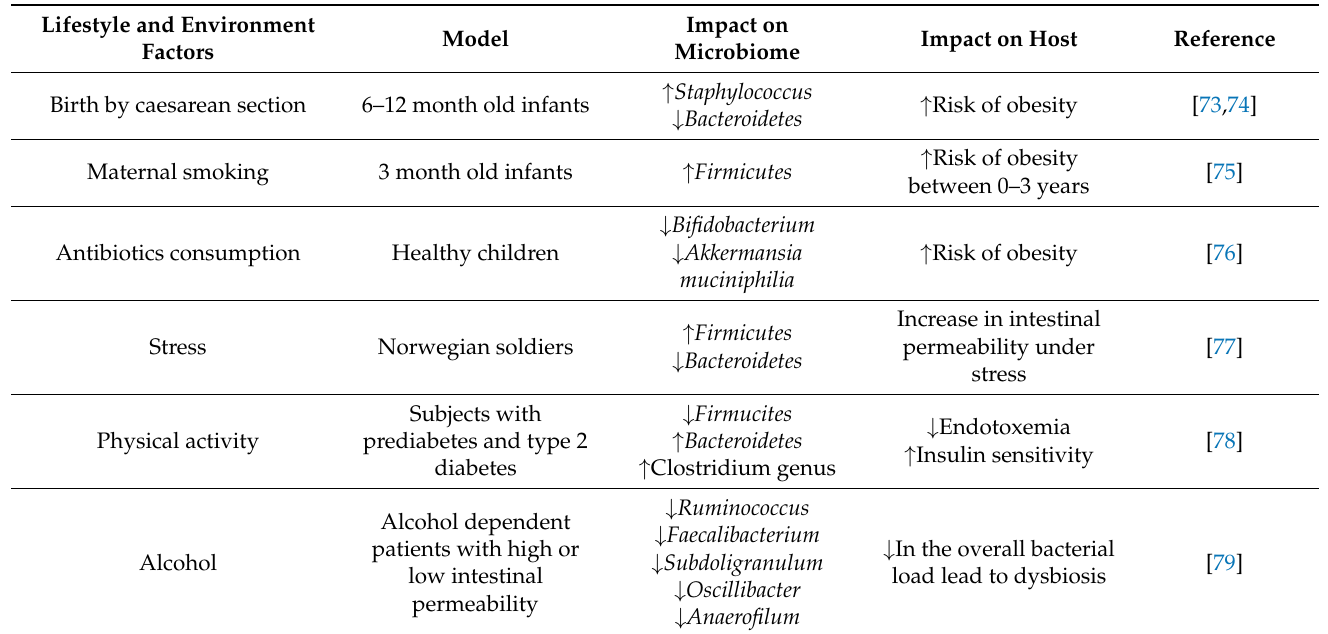
Table 3. Effect of certain lifestyle and environmental factors on gut microbiota ↑ : increased; ↓ :